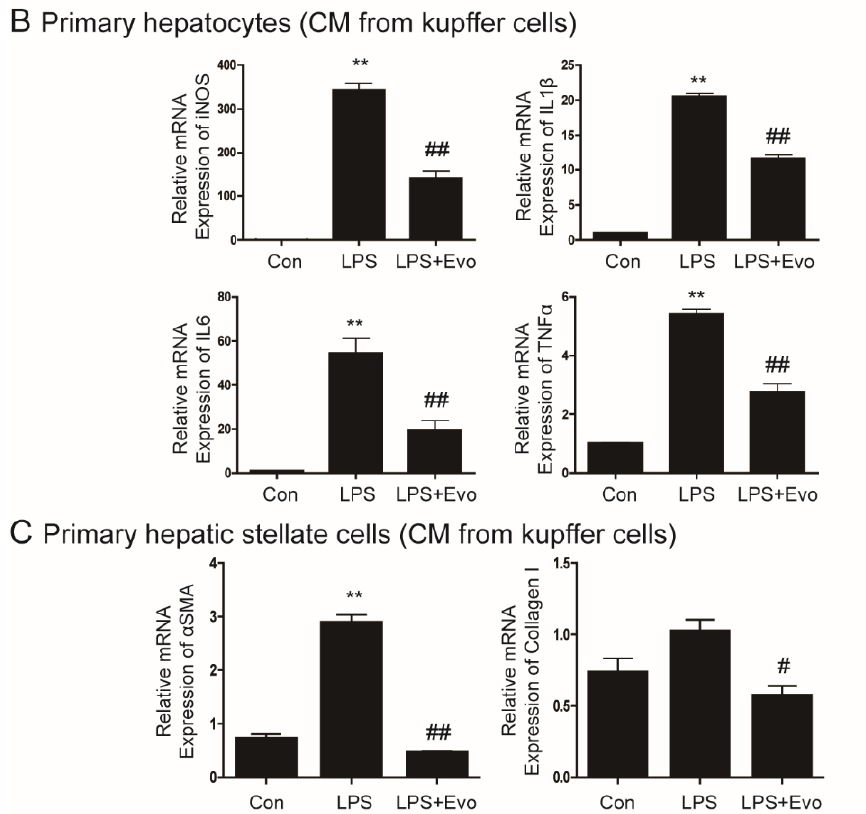
Figure 1. The inhibitory effect of evogliptin on lipopolysaccharide (LPS)-induced cytokine secretion from Kupffer cells. ( A ) Primary Kupffer cells (KC) were pretreated with LPS for 2 h and then treated with evogliptin. After 24 h, the media was collected and measured using ELISA. The data are the mean ± SEM of three independent measurements. ** p < 0.01 relative to the control, ## p < 0.01 relative to LPS. ( B ) Representative real-time RT-PCR analysis of the expression levels of iNOS, IL1 β , IL6, and TNF α in primary hepatocytes treated with conditioned media (CM) from LPS-treated primary KC. The data are the mean ± SEM. ** p < 0.01 relative to the control, ## p < 0.01 relative to LPS. ( C ) Representative real-time RT-PCR analysis of the expression levels of α SMA and collagen in primary hepatocytes treated with CM from LPS-treated primary hepatic stellate cells. Data are the mean ± SEM. ** p < 0.01 relative to the control, # p < 0.05, ## p < 0.01 relative to LPS.